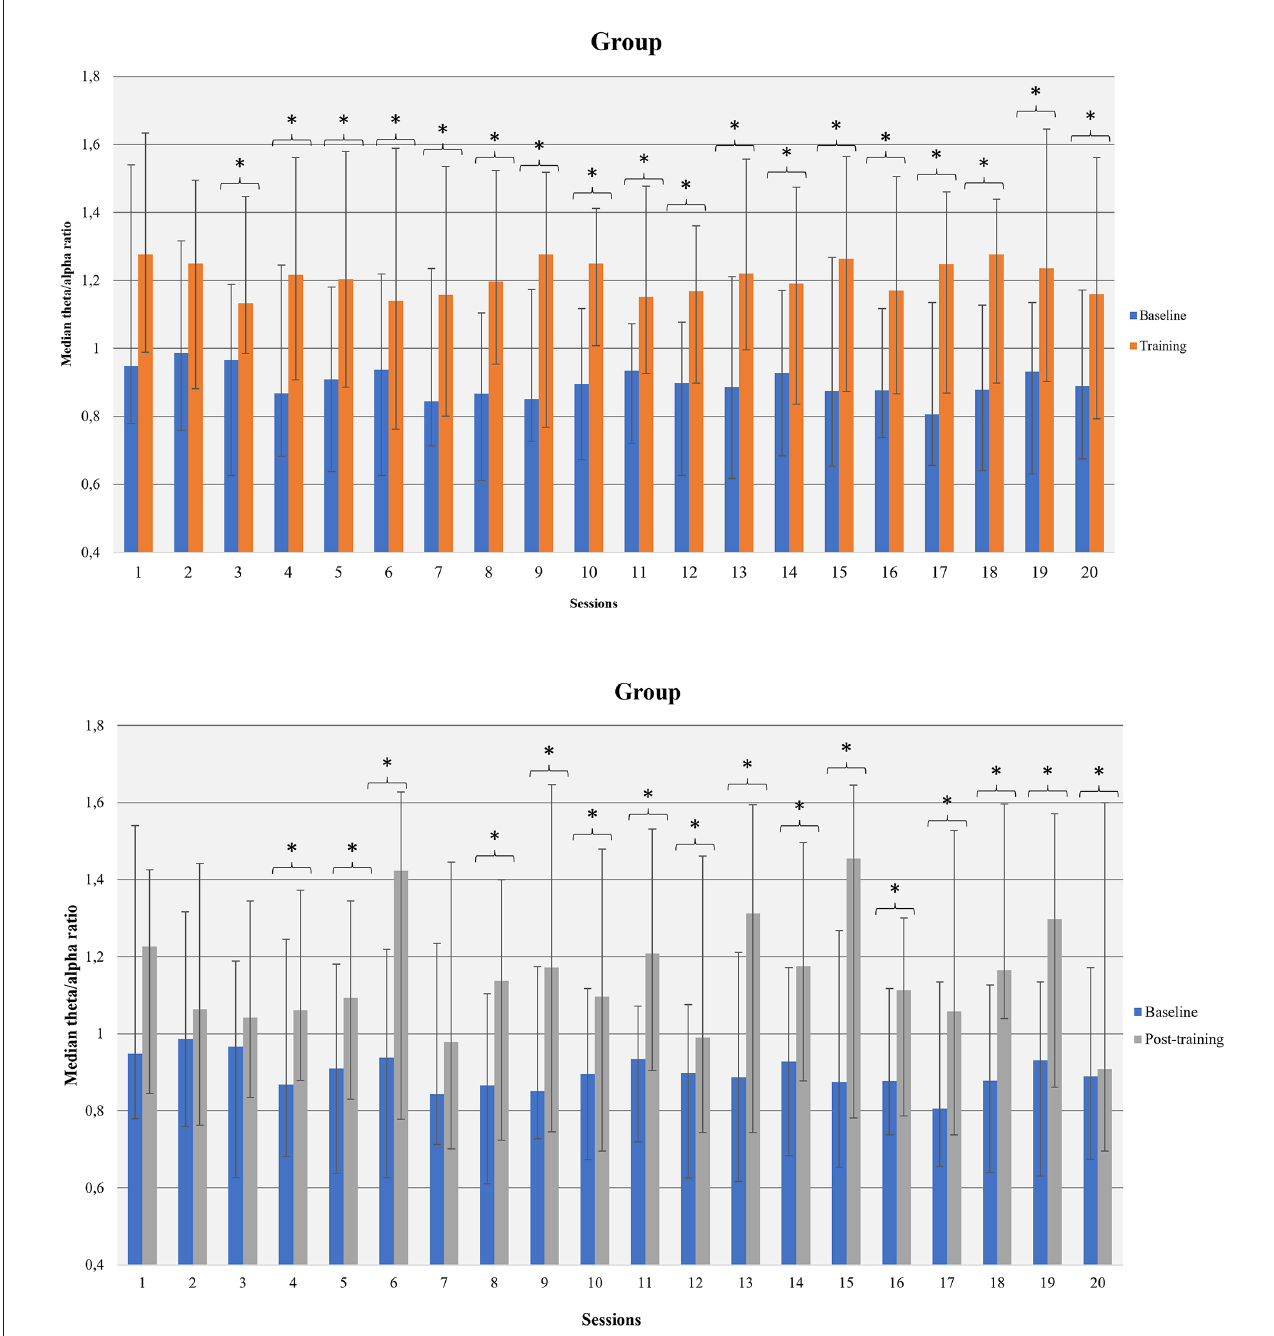
FIGURE6 Theta/alpha ratio was increased within NF sessions (between baseline and session average and before-after training; within NF learning) in the whole group of participants. ∗ p < 0.05.